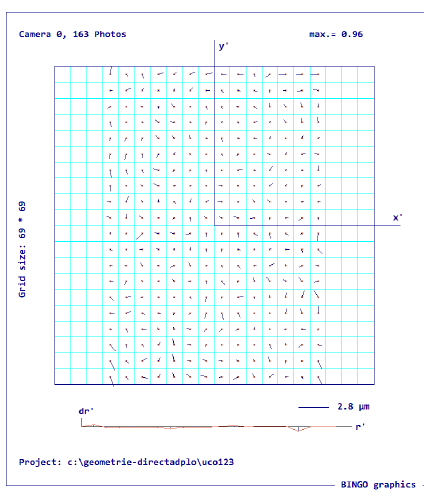
Fig.4: Image residual plot from an UltraCam Osprey flight mission (panchromatic nadir, 80 mm focal length) Maximum residuals are at 1 µm level.